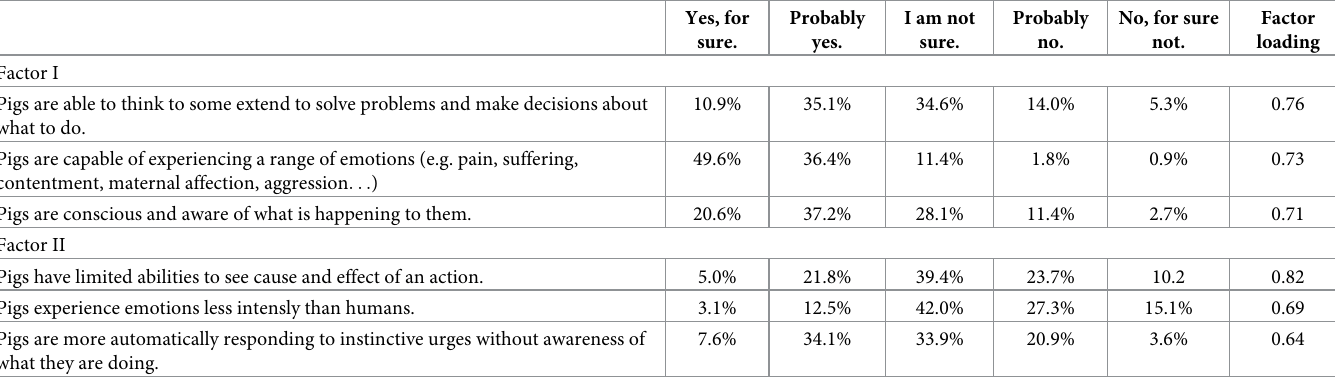
Table 3. Responses to the six statements measuring belief in pigs’ mind in % of participants (N = 1,019) and results of factor analysis for the six statements.